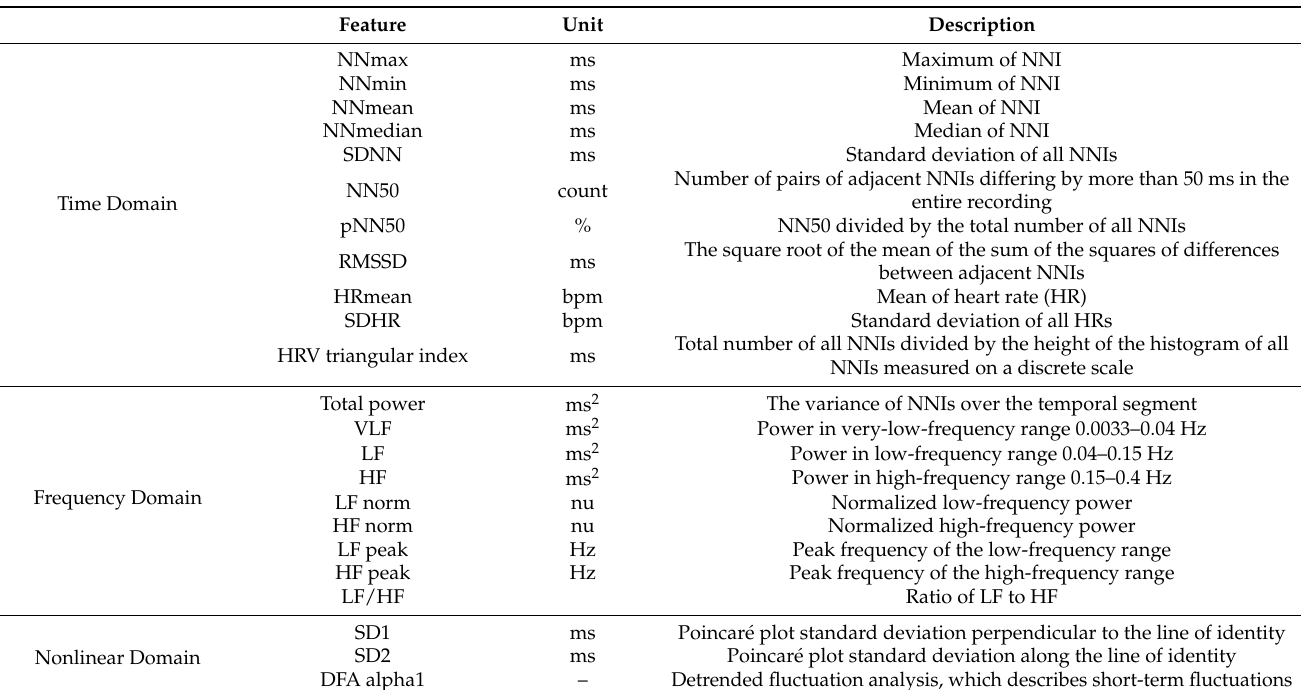
Table 2. Selected HRV features in the time domain, frequency domain, and nonlinear domain.